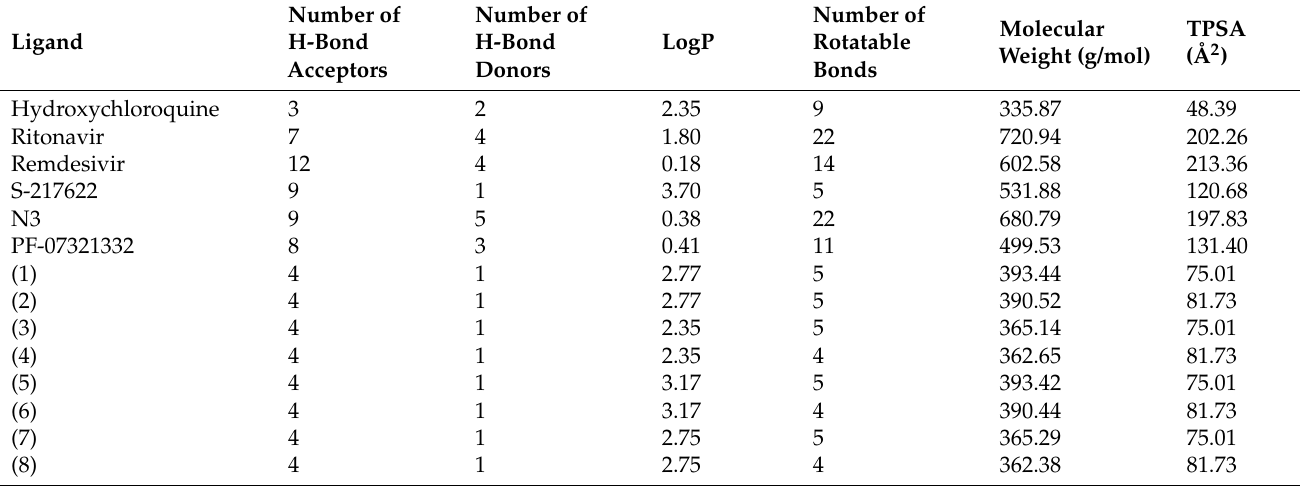
Table 1. Molecular properties of ligands calculated by SwissADME